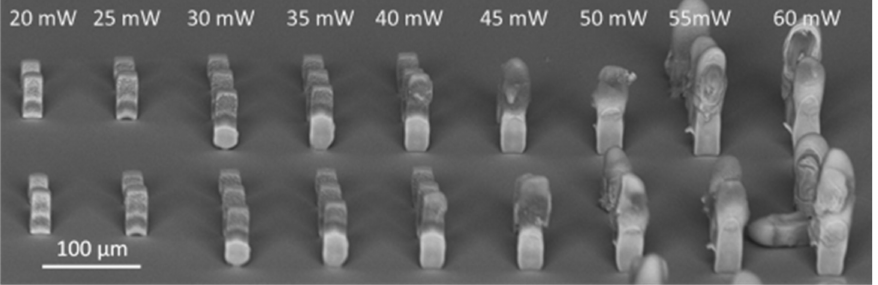
Figure 5. SEM image of structures printed on a glass substrate in a curing depth of 80 µ m.